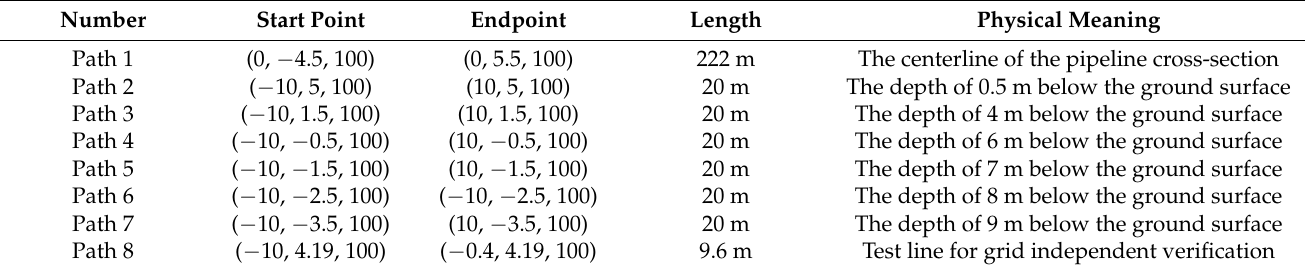
Table 2. Coordinates and physical meaning of auxiliary paths.